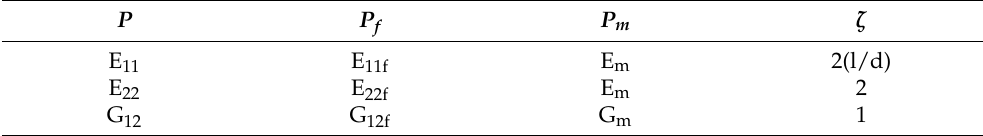
Table 2. Empirical parameter 𝜁 for various effective mechanical properties.